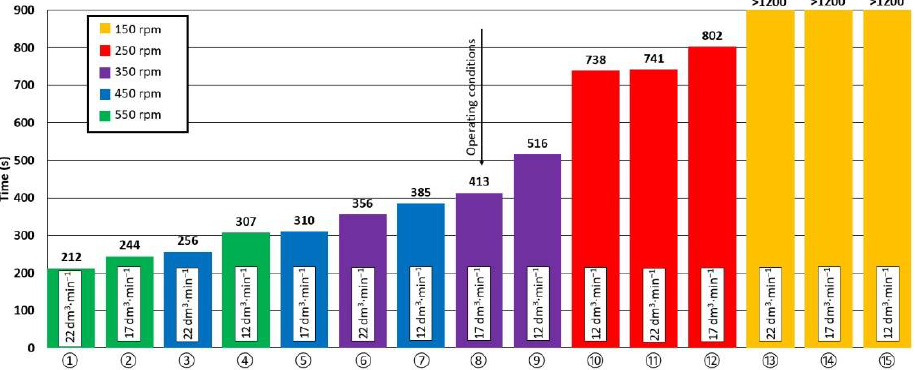
Figure 8. The minimum times of oxygen removal from the model liquid to the content of 1 ppm. It is evident from the graph in Figure 8 that, with a few exceptions, shorter oxygen- concentration reduction times to 1 ppm were achieved at higher argon flow rates and